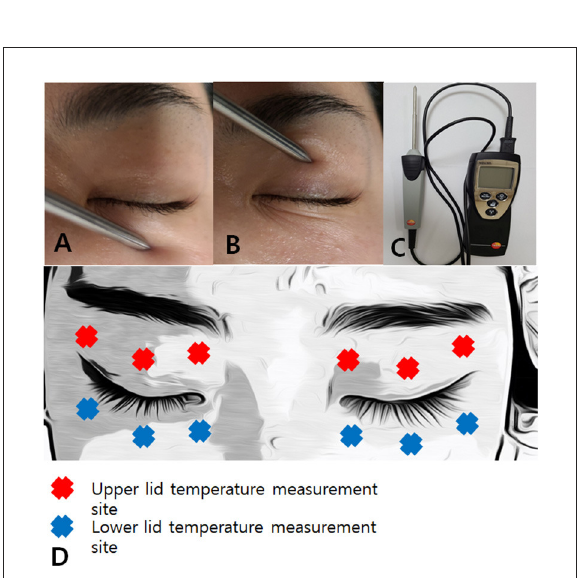
FIGURE2 A picture of skin temperature measurement of lower lid (A) and upper lid (B) and a picture of a thermometer (Testo 925, one-channel temperature measuring instrument T/C Type K, Testo AG, Germany) (C) . Skin temperature measurement site including three periocular areas of the upper and lower lids (D)